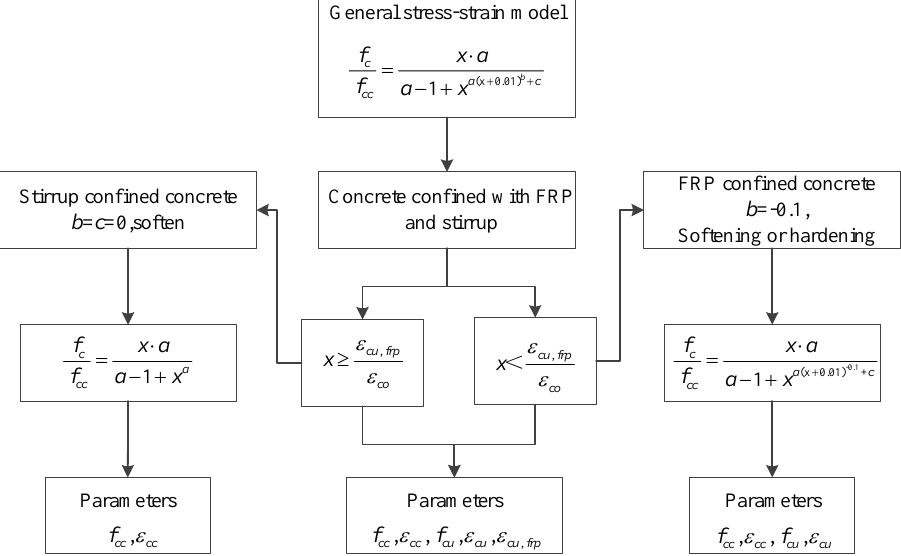
Figure 11. Flowchart for the application of the general model.